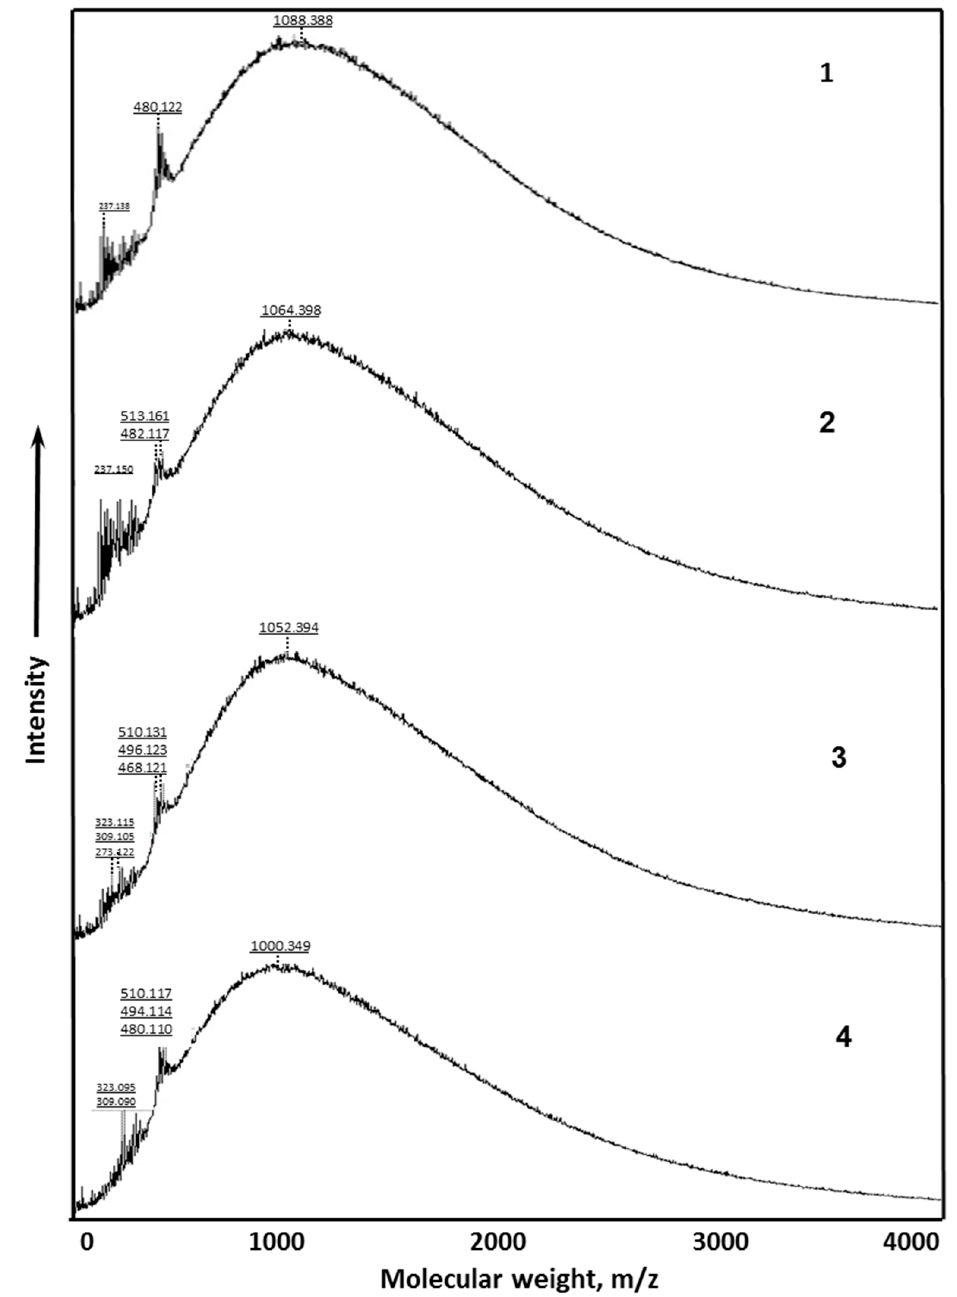
Figure 5. MALDI mass spectra of asphaltenes of samples of extracted extracts: initial (1) and experimental products (2,3,4).